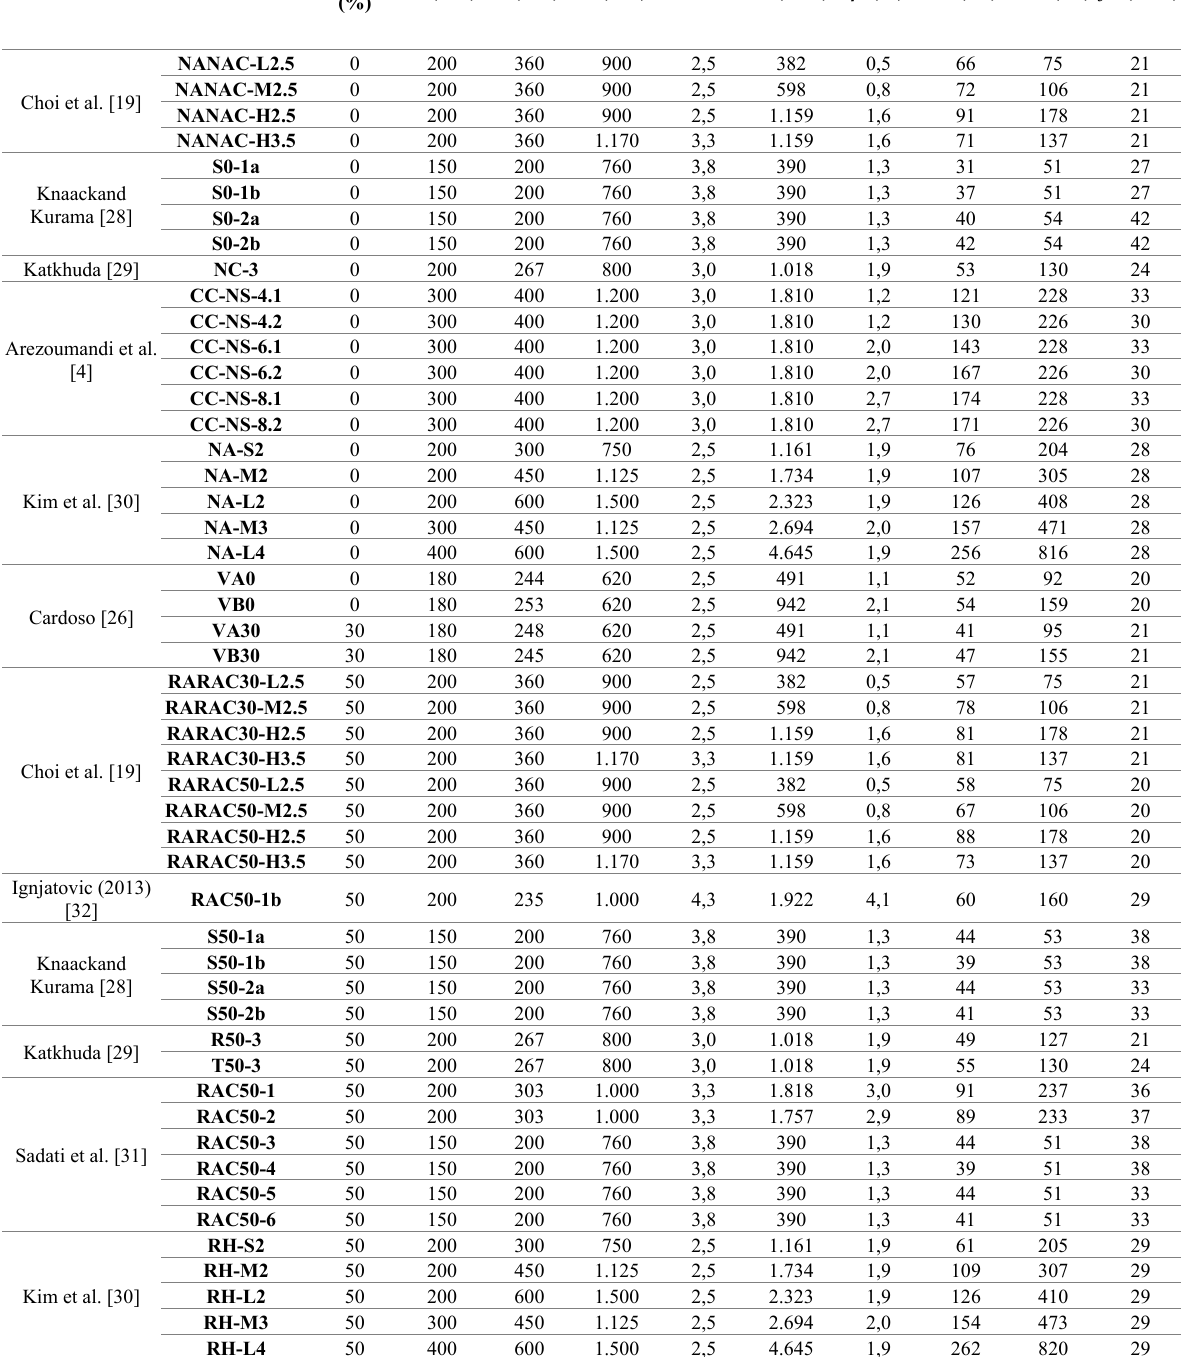
Table A2. Database of tests on reinforced concrete beams without shear